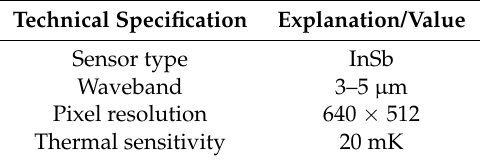
Figure 2. The optical excitation thermography experimental set-up. Table 2. The IR camera ’FLIR Phoenix’ technical